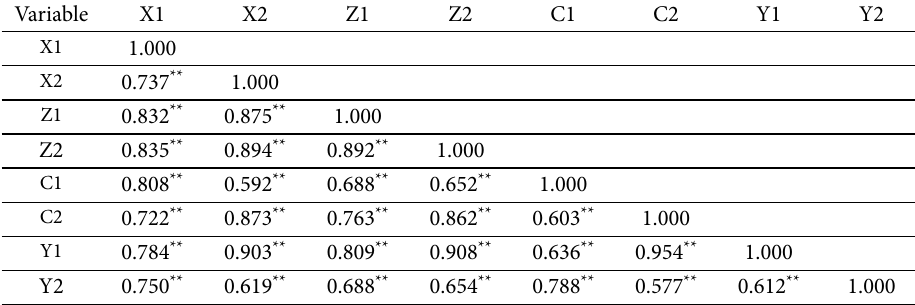
Table 2. Spearman’s rho correlation